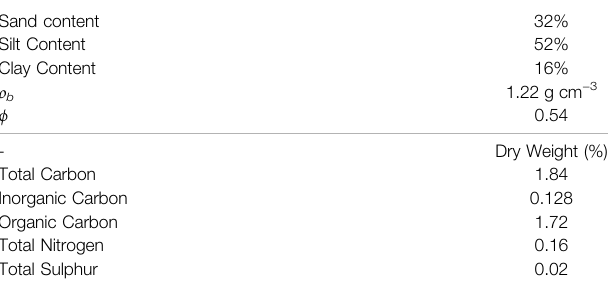
TABLE 1 | Characteristics of rare site soil used for column experiment. Sand content